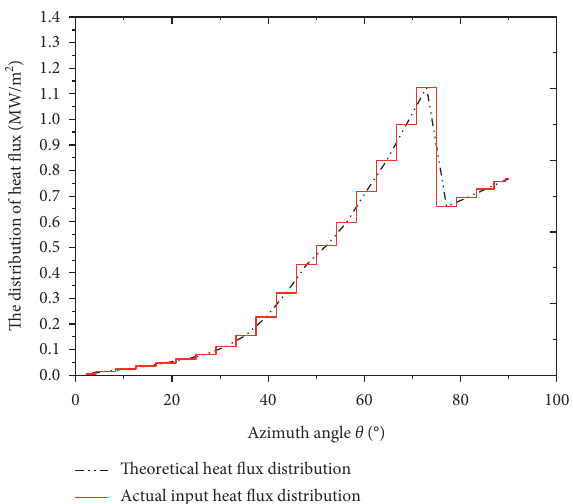
Figure 6: Theoretical and actual input heat flux distribution in zone 23.